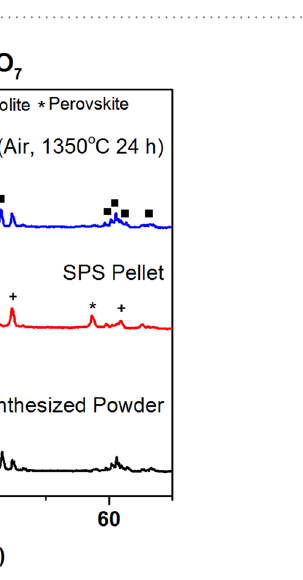
Figure 8. Phase amounts and corresponding XRD patterns during heating and isothermal hold at 1350 °C of CaZr 0.6 Ce 0.4 Ti 2 O 7 .